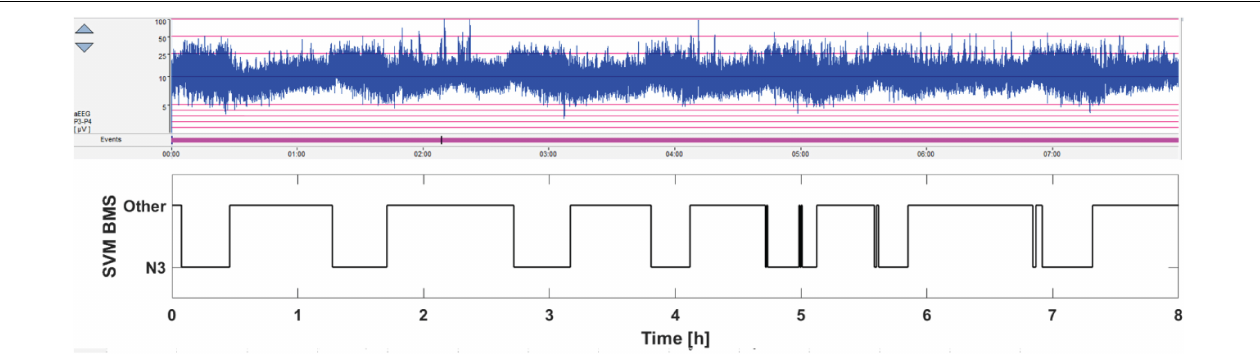
FIGURE 5 | Pilot 8 h monitoring of sleep cycling in the NICU. The current standard practice is to observe SWC pattern in the aEEG trend (above), which refers to the alternation between thicker and thinner trends. The thicker aEEG trend comes from the intermittent, trace alternant/discontinue background pattern, which characterizes quiet (“deep”) sleep state. In contrast, the thinner aEEG trends come from the more continuous EEG pattern that characterizes the active sleep state. The BMS-based sleep monitoring is shown below. Note the faithful correspondence between thicker epochs in the aEEG trend and the deep sleep output of the BMS